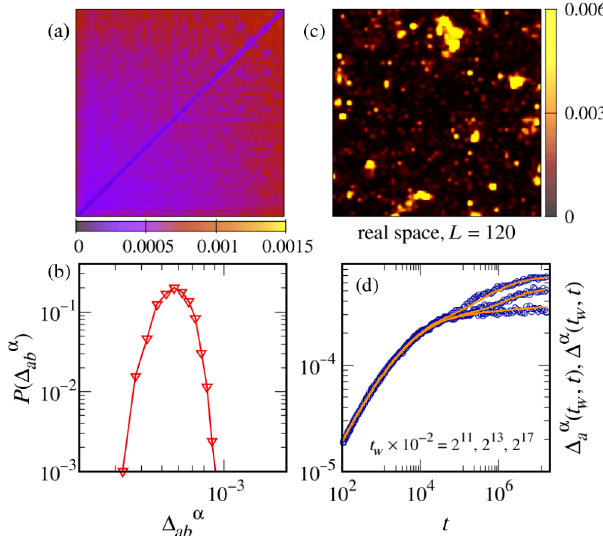
FIG. 15. Self-averaging in a single sample α for N ¼ 16 384 at ð t ¼ 2 18 × 100 Þ , with N Z ¼ 600 . (a) Heat map of Δ α w ab clones. (b) Corresponding probability distribution P ð Δ α ð R Þ for two randomly selected clones a (c) Distance field Δ α ab ¼ 2 18 × 100 . (d) Aging exhibited in the MSD of a and b at t w single clone a (blue symbols) and in the MSD averaged over ¼ 100 clones (yellow N c